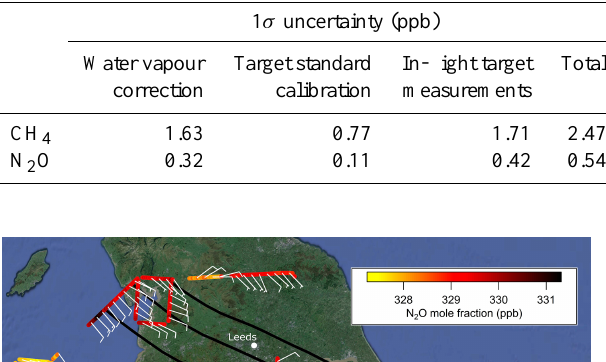
Table 4. Known component and nominal total uncertainties for the QCLAS measurement of CH 4 and N 2 O, calibrated using the pressure-differentiated method.